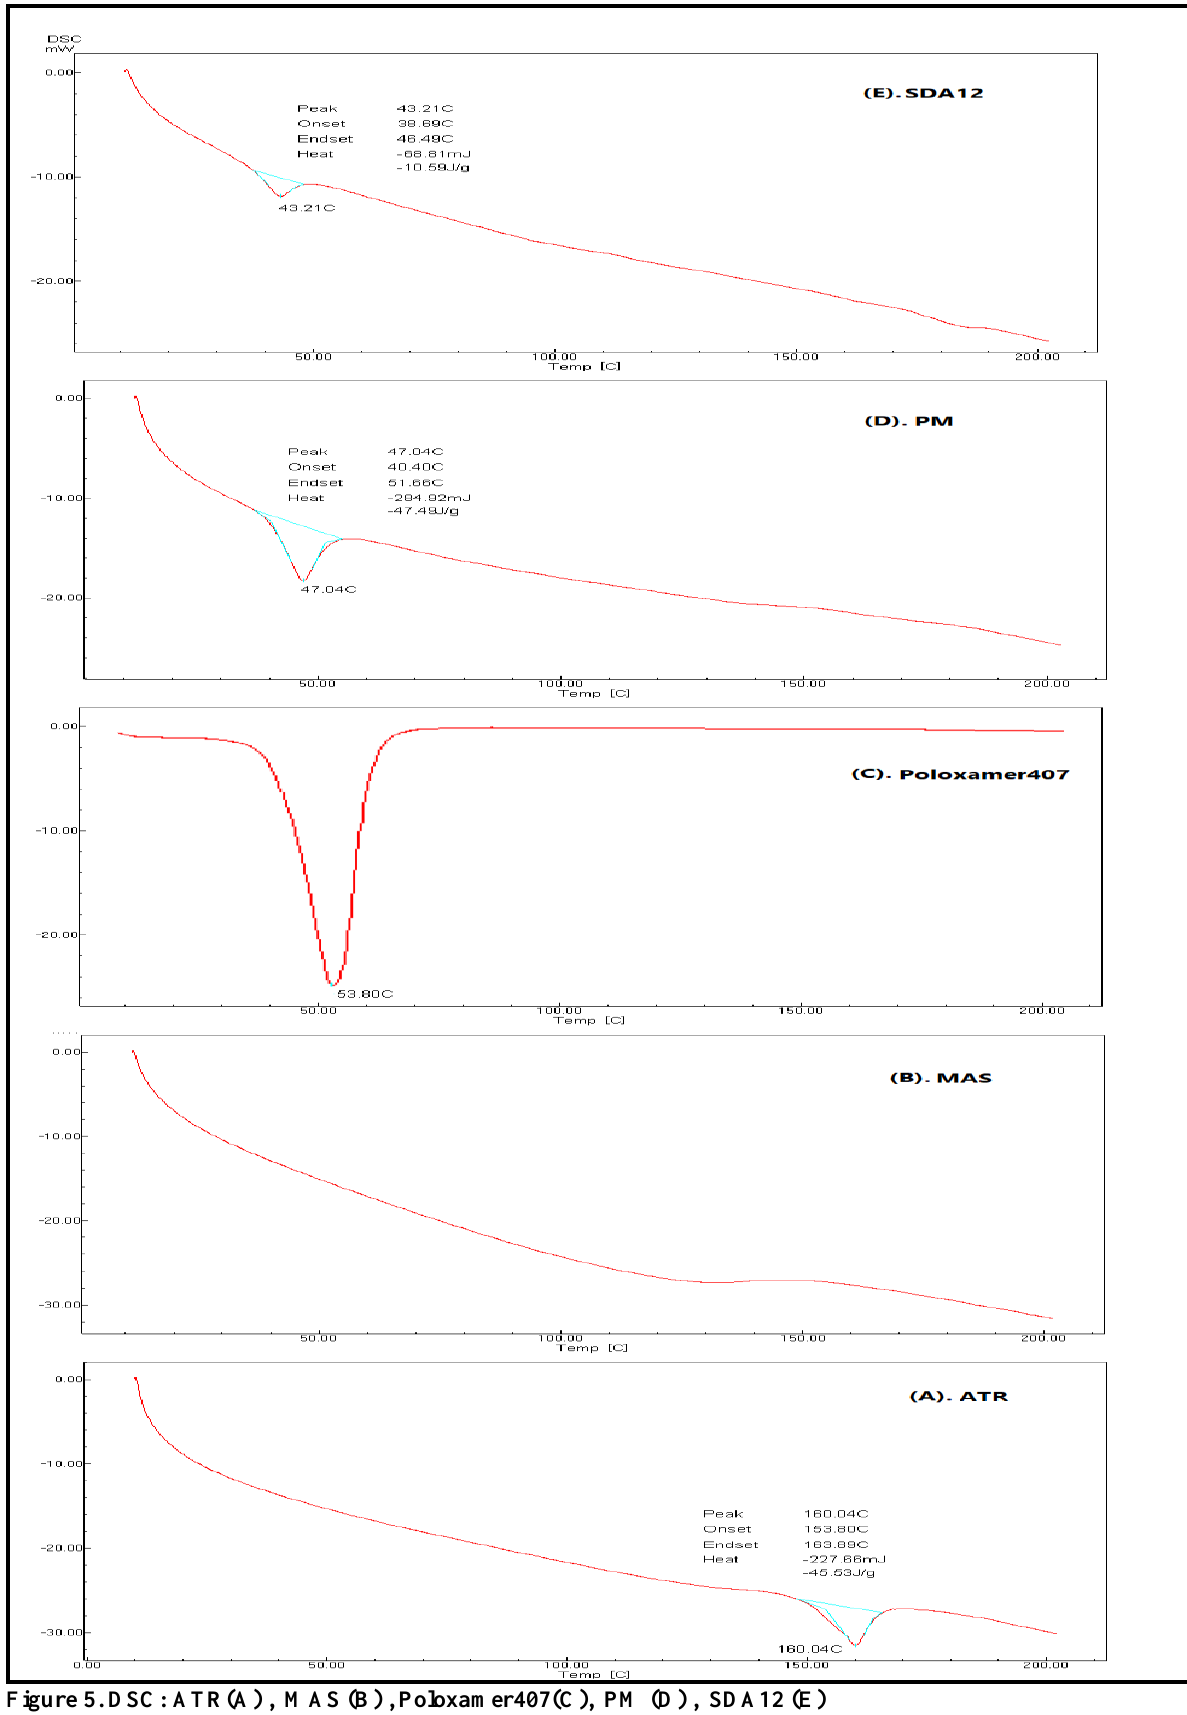
Figure 5. DSC: ATR(A) , MAS (B) , Poloxamer407(C), PM (D) , SDA12